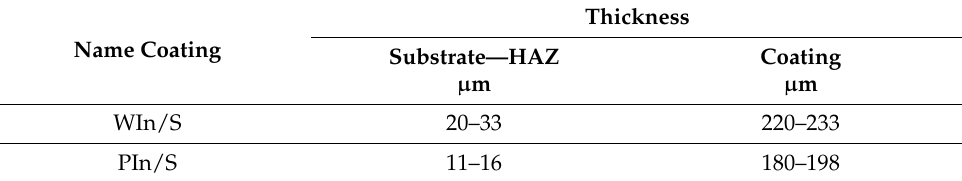
Figure 3. SEM cross-section of Inconel 625 coatings onto the S235JR substrate produced by laser cladding method with the use of: ( a ) Wire and ( b ) Powder. Table 3. Thickness of the substrate—HAZ and Inconel 625 coatings onto the S235JR steel.